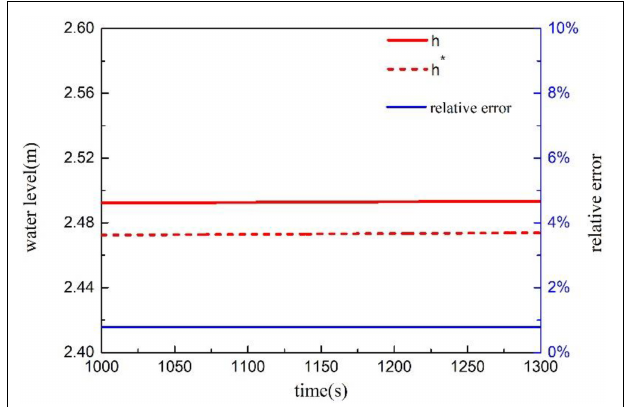
FIGURE 3 | The relative measurement error under steady state conditions.